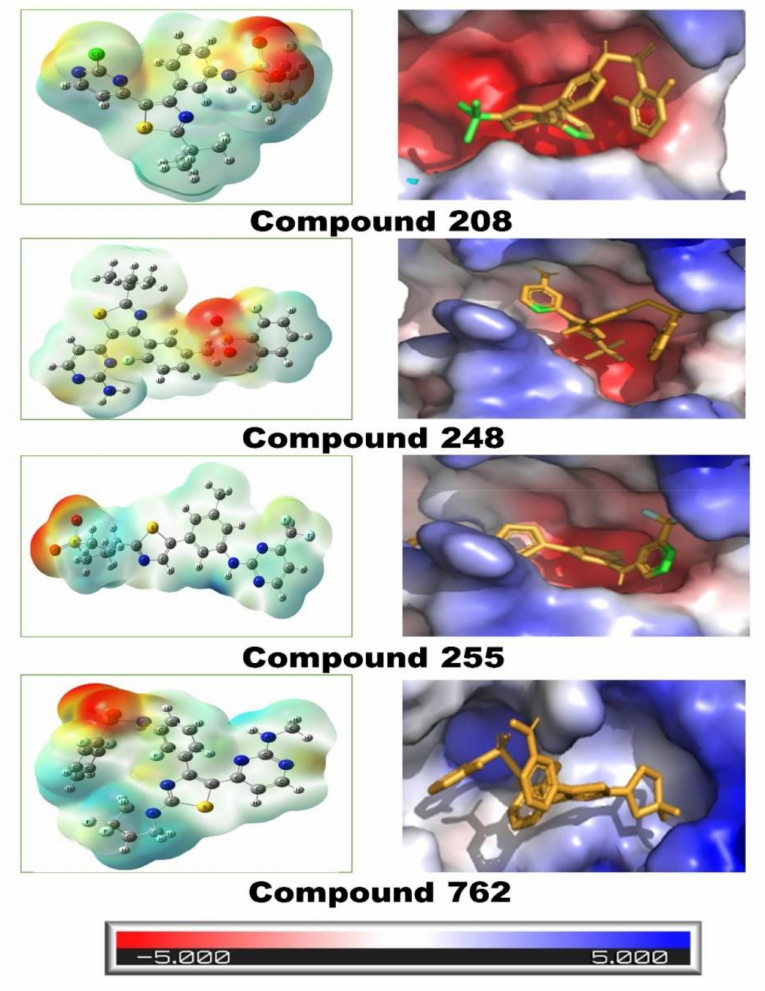
Figure 8. Electrostatic surface potential map of all ligand